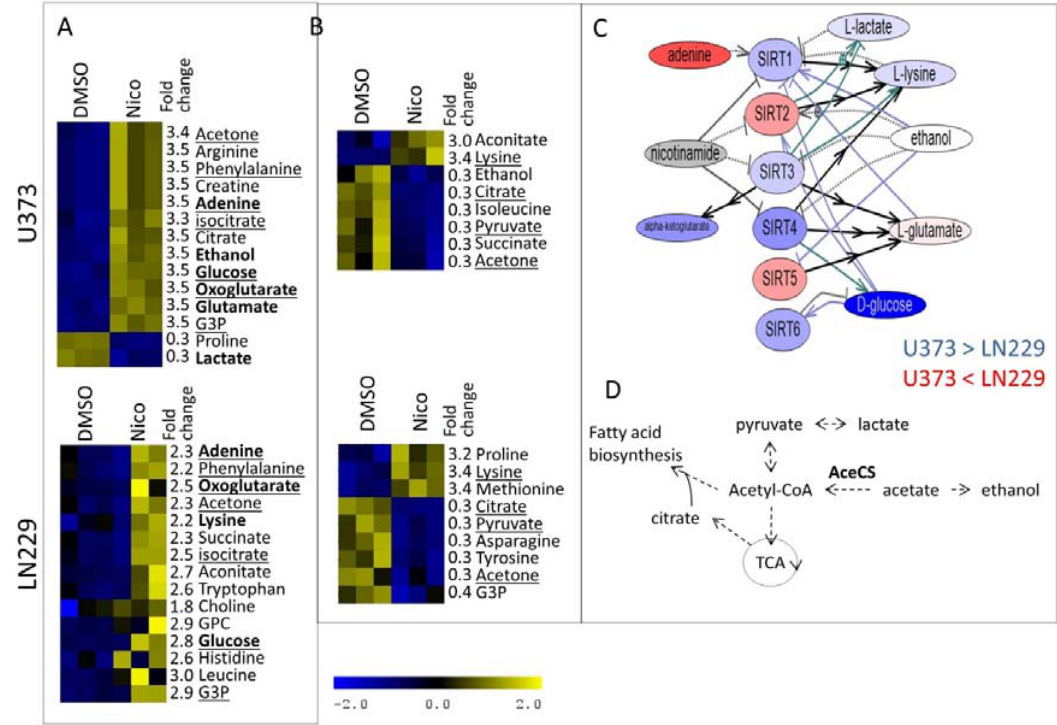
Figure 7. Major metabolic differences induced by nicotinamide (Nico) treatment in intracellular ( A ) and extracellular ( B ) samples. Metabolites that are determined as the most significantly changed by treatment in both U373 and LN229 cells are